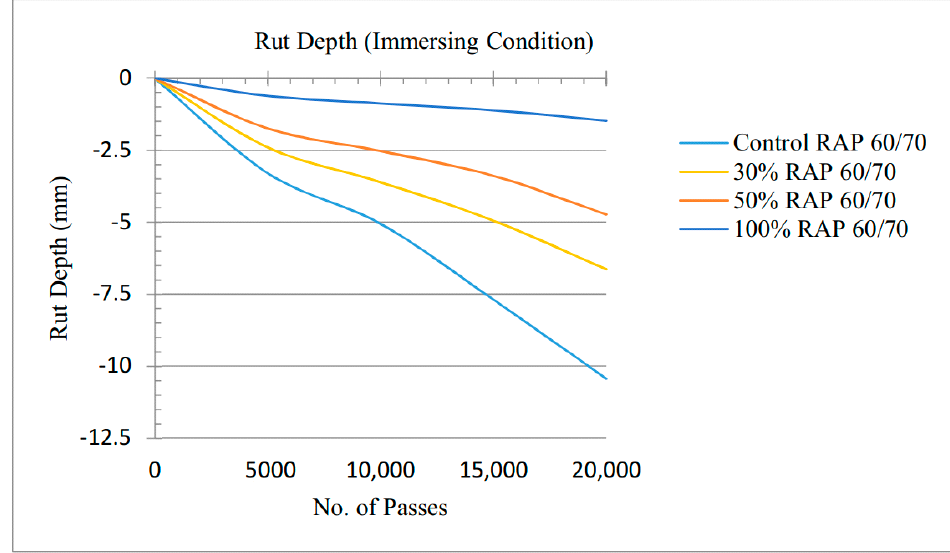
Figure 11. Rutting depths under immersing conditions.